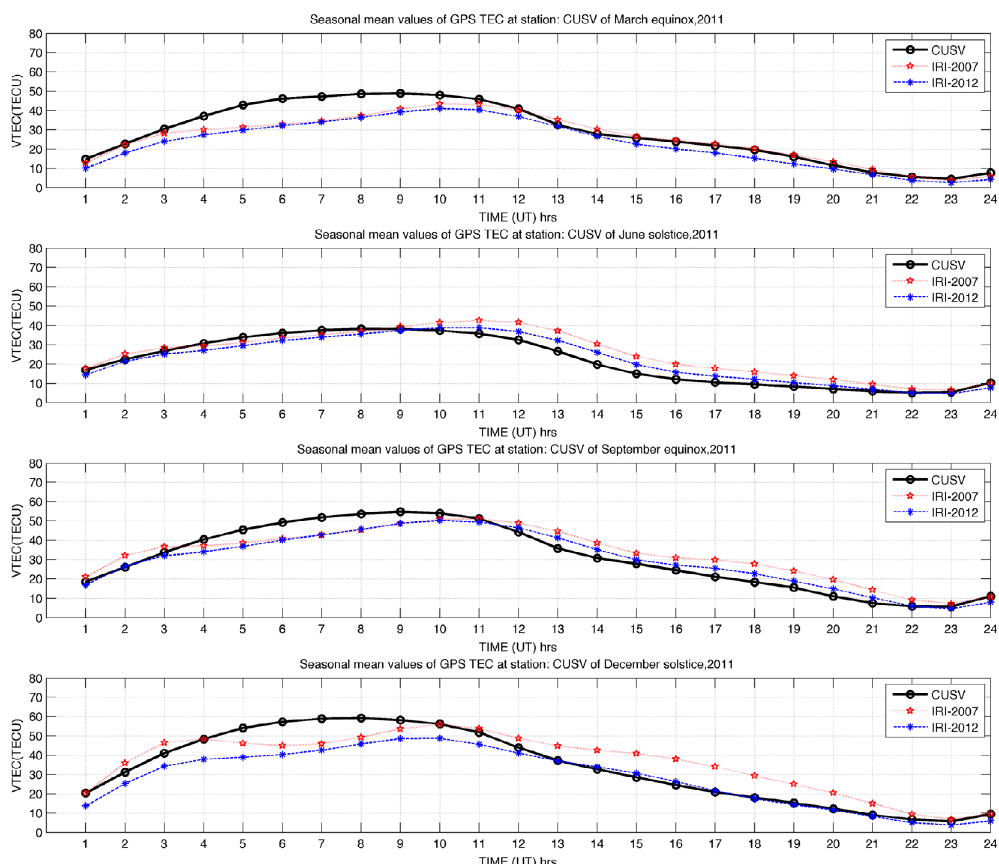
Figure 7. Seasonal mean values of GPS TEC, IRI-2007 TEC and IRI-2012 TEC at CUSV station during the period 2011.